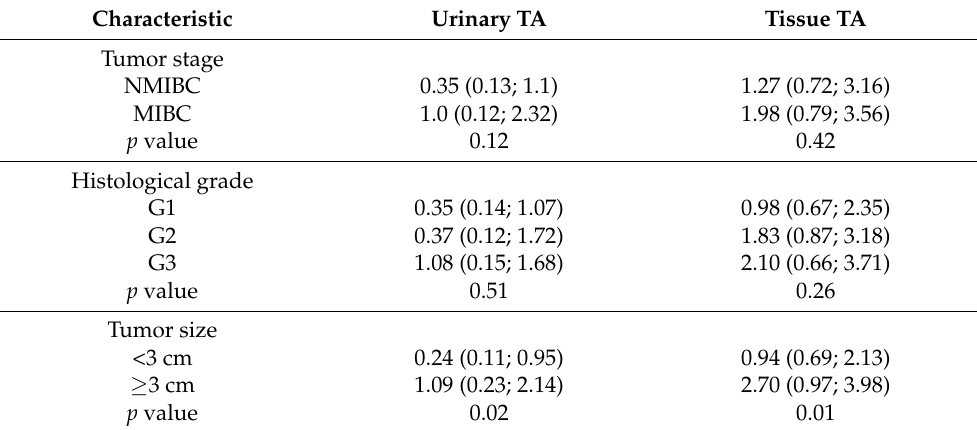
Table 2. Relationship between Telomerase activity (TA) level and clinicopathologic